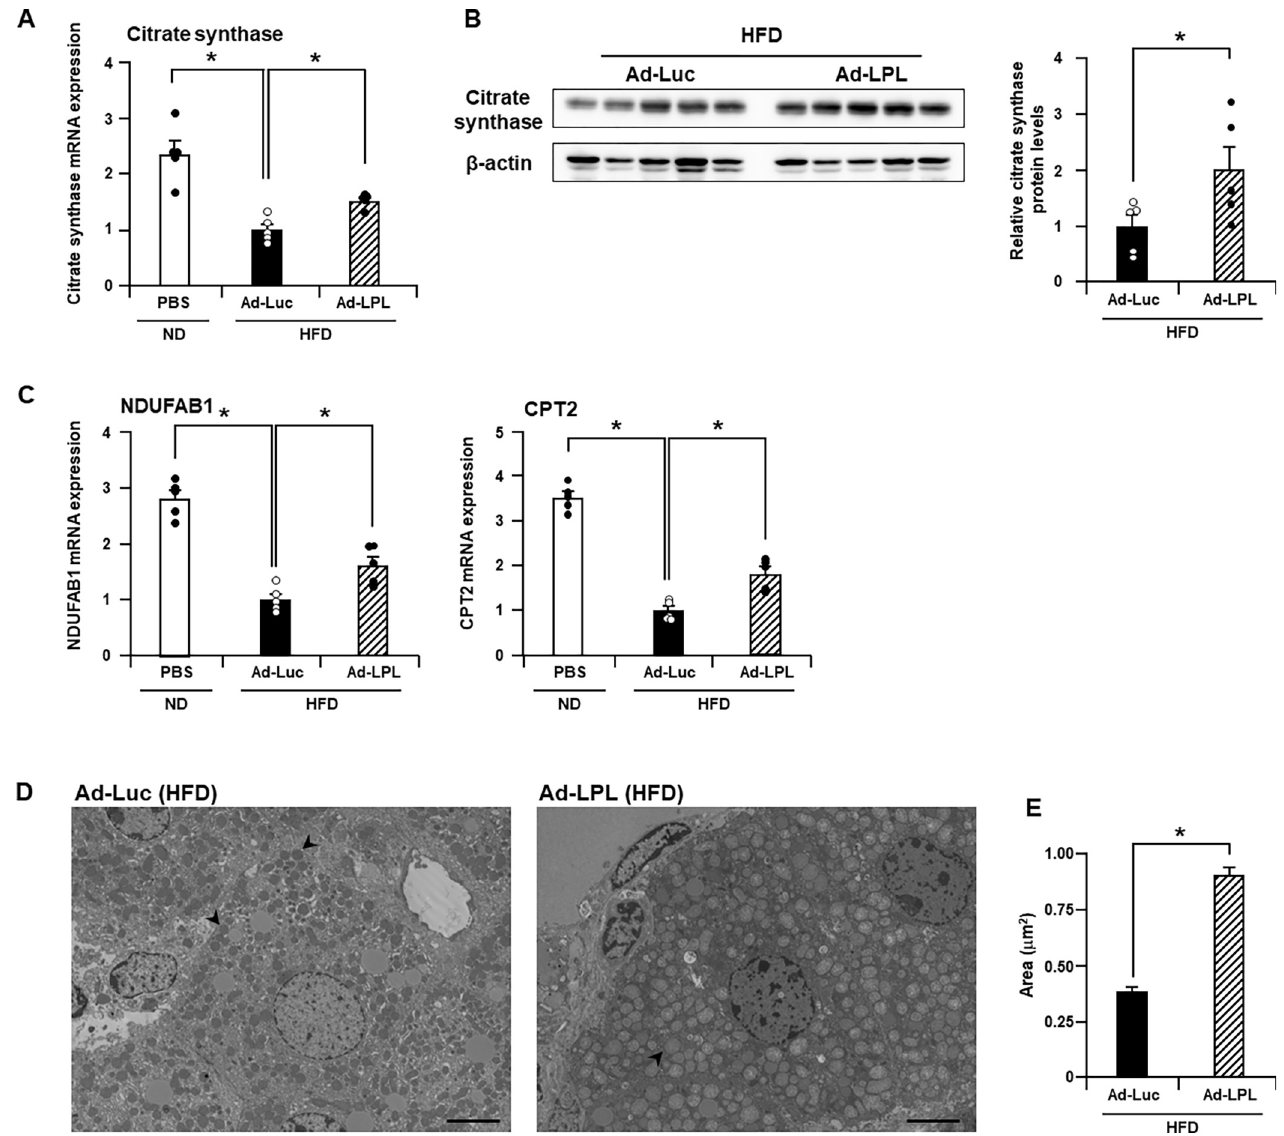
Fig 4. Hepatic LPL overexpression maintains mitochondrial content in HFD-fed mice. Male C57BL/6 mice were intravenously treated with Ad vectors via the tail vein and were simultaneously fed HFD. PBS-treated mice were fed ND throughout the experimental period. Two weeks after administration of Ad-LPL, Ad-Luc, or PBS, (A, C) expression of mitochondrial genes in the liver determined using quantitative RT-PCR. The data were normalized to the corresponding values in the Ad-Luc-treated group. One-way ANOVA with Dunnett’s post hoc tests was used for multiple comparisons. Hepatic (B) citrate synthase protein levels in male C57BL/6 mice 2 weeks after administration of Ad-LPL or Ad-Luc determined using western blot analysis. The quantification data were normalized to the corresponding value in the Ad-Luc-treated group. The Mann–Whitney U test was used to compare the differences between two independent groups. (D) The area of mitochondria in the liver was assessed via transmission electron microscopy analysis. Arrowheads indicate mitochondria. Bar = 5 μ m. (E) The area of mitochondria was determined by measuring the area of mitochondria in the cell using Fig 4D. The Mann–Whitney U test was used to compare the differences between two independent groups. The data are expressed as the mean ± standard error (A–C: n = 5, E: n = 151–155). � , P < 0.05 vs. Ad-Luc. specific overexpression of LPL may hydrolyze diacylglycerol and suppress diacylglycerol-medi- ated activation of protein kinase C ε and subsequent impairment of insulin signaling. There- fore, decreasing ectopic lipid content in non-adipose tissue by promoting its tissue oxidation would improve insulin sensitivity. Nevertheless, further research is needed to confirm these